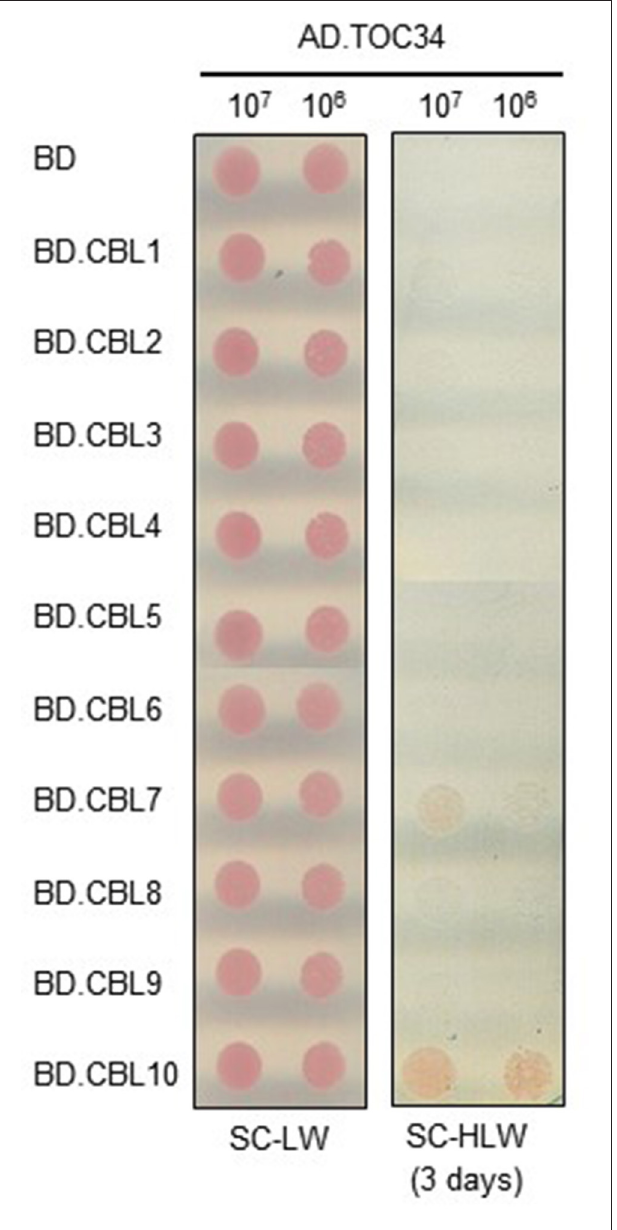
FIGURE 2 | Interaction specificity of TOC34 with CBLs in a yeast two-hybrid assay. Yeast cells (Y190 strain) were cotransformed with the combinations of the BD and AD constructs as indicated and selected on the synthetic complete media lacking Leu and Trp (SC-LW). Cotransformed yeast cells were cultured, serially diluted, and spotted onto the indicated media. Yeast growth on the synthetic complete media lacking His, Leu, and Trp (SC-HLW) indicates interaction.